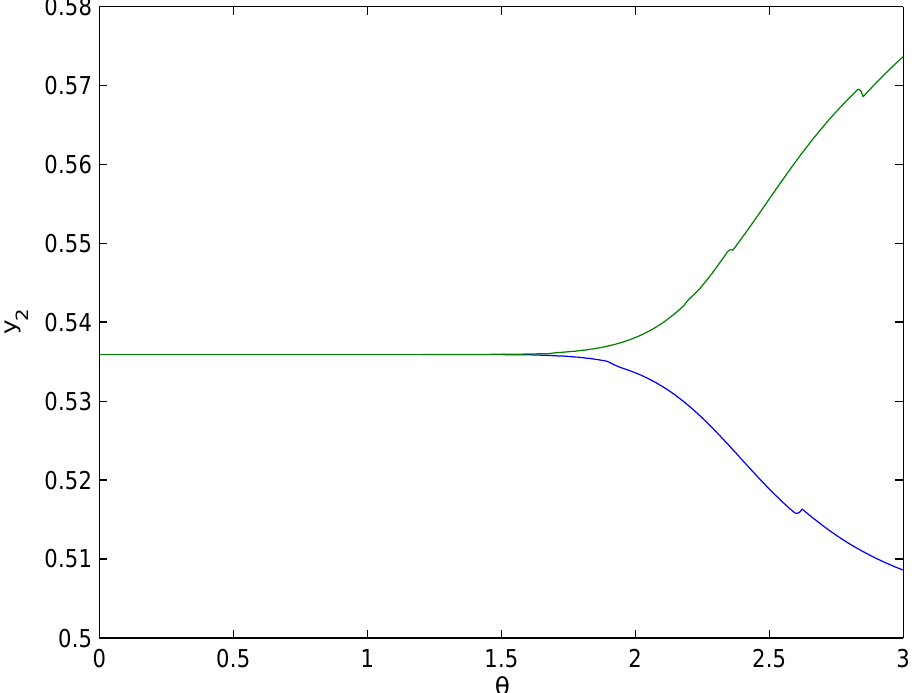
. The bifurcation value is approximately 1